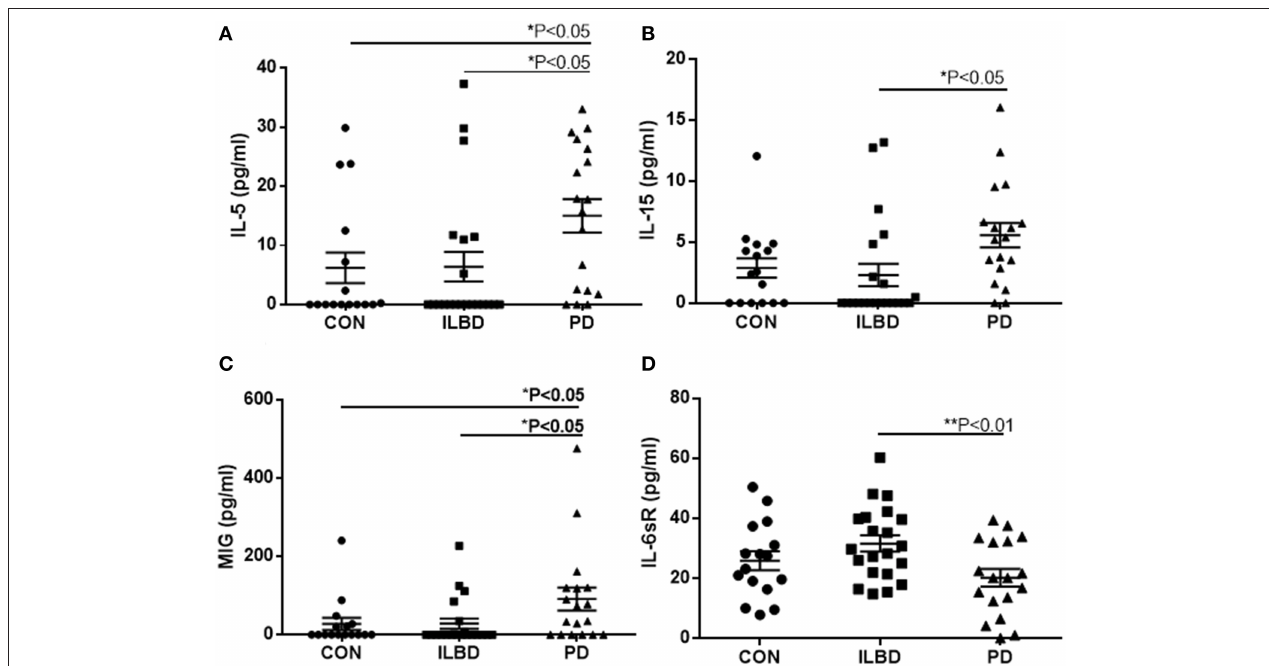
FIGURE 2 | Scatter plots showing distribution of results for proteins that showed disease group differences in substantia nigra samples. Disease group differences for interleukin-5 (IL-5) (A) , IL-15 (B) , monokine induced by gamma interferon (MIG) (C) , and IL-6 soluble receptor (IL-6sR) (D) . Statistical analysis by One-way analysis of variance (ANOVA) with Fisher LSD post-hoc test for between group differences.